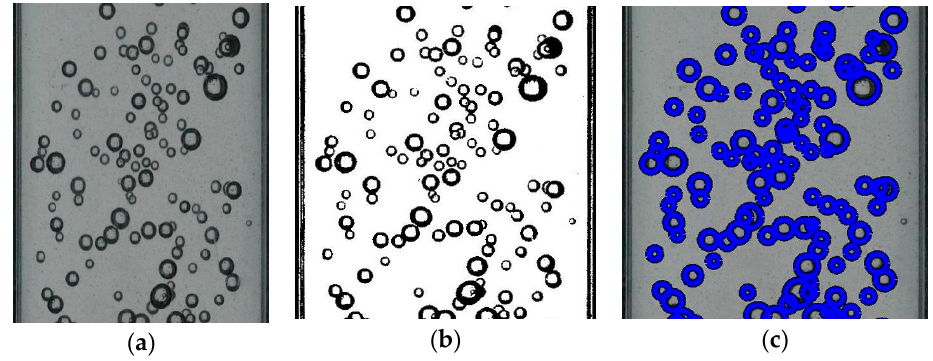
Figure 3. Example of picture processing: ( a )—original picture; ( b )—binared picture; ( c )—picture after determination of bubbles.